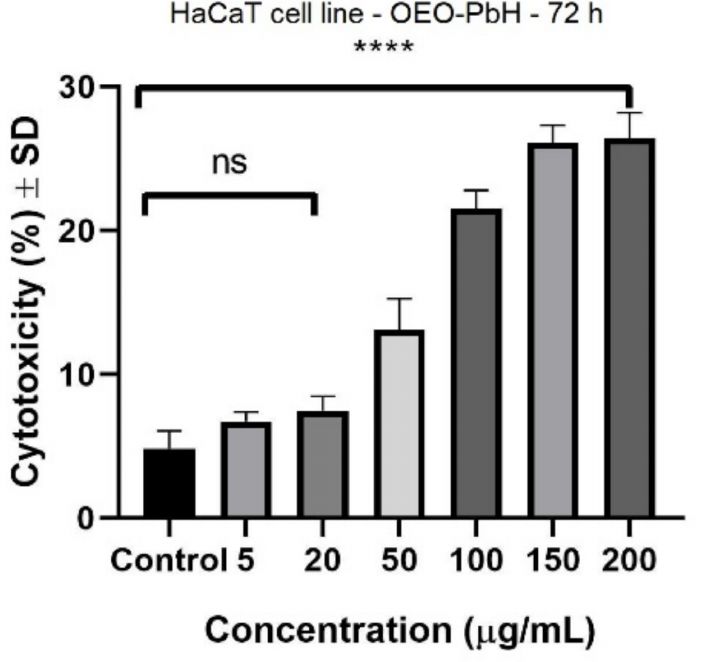
Figure 6. The cytotoxicity of different concentrations of OEO-PbH (5, 20, 50, 100, 150, 200 µ g/mL) at 72 h post-stimulation. Data are represented as mean ± SD. Comparison among groups was made with one-way ANOVA and Dunnett’s multiple comparison test (**** p < 0.0001 vs. Control; ns = not